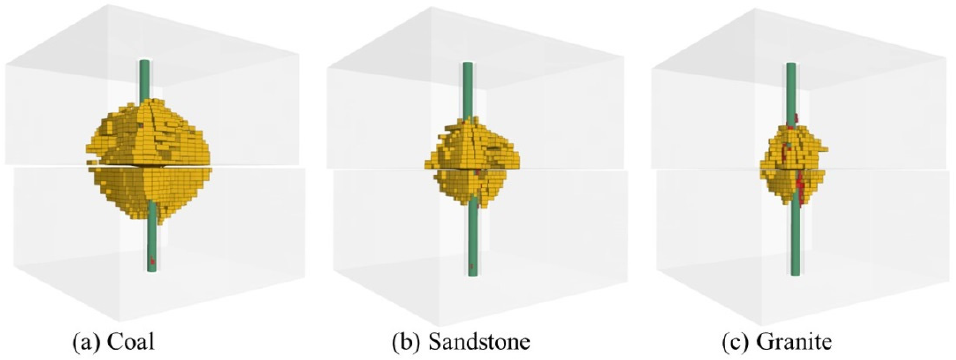
Figure 6. Distribution of plastic zones on the surrounding rock.